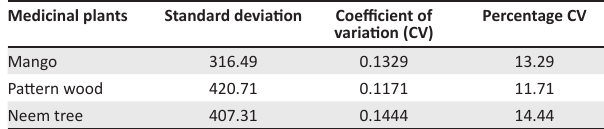
TABLE 8: Coefficient of variation in prices (gatherers).